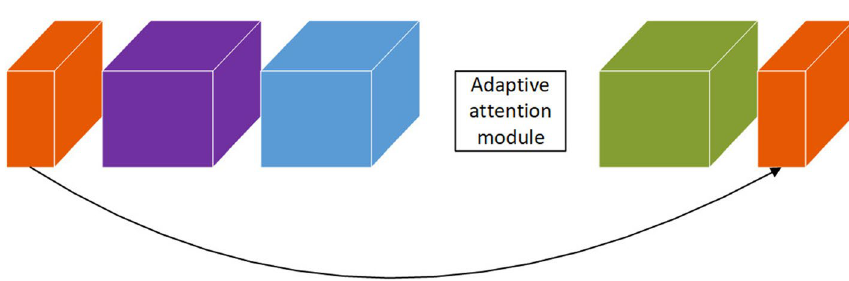
Figure 9. Inverted residual module. ASA or ACA is used to recalibrate the feature maps (blue cube) generated by the point-wise convolution layer within the IRM module.